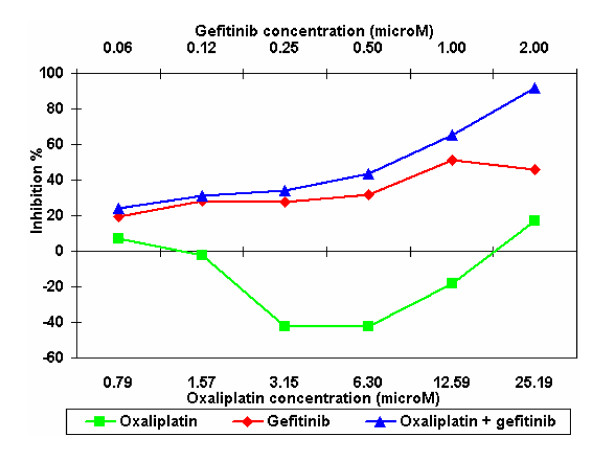
Tumour growth inhibition by gefitinib vs. gefitinib + oxaliplatin in a NSCLC. Legend The combination of oxaliplatin + gefitinib has a positive effect compared with single agent oxaliplatin which is inactive.